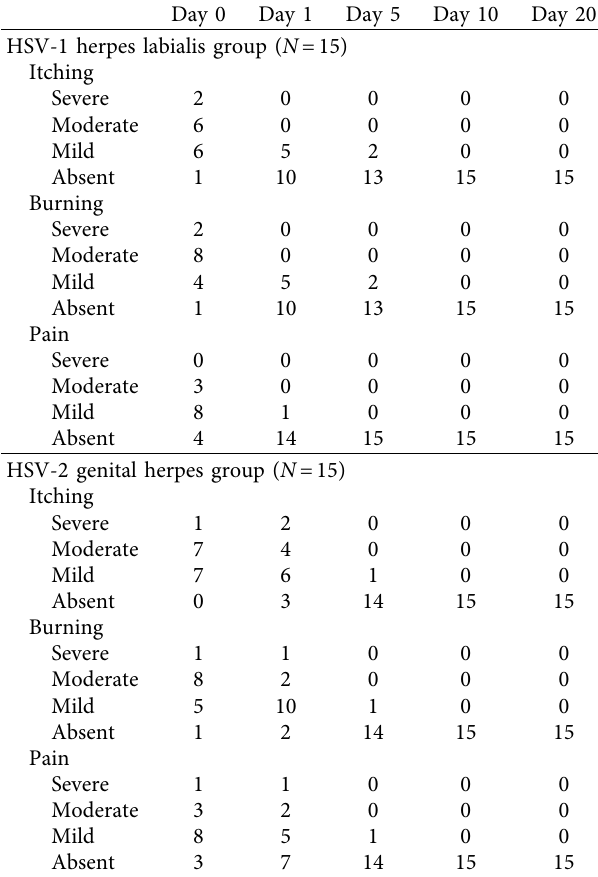
Table 3: Patients classifed by symptoms intensity during the treatment